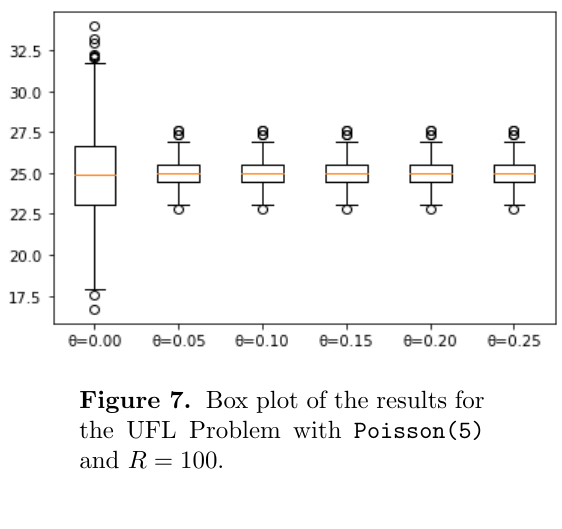
Figure 6. Box plot of the results for the UFL Problem with Binomial(10, 0.5) and R = 100.